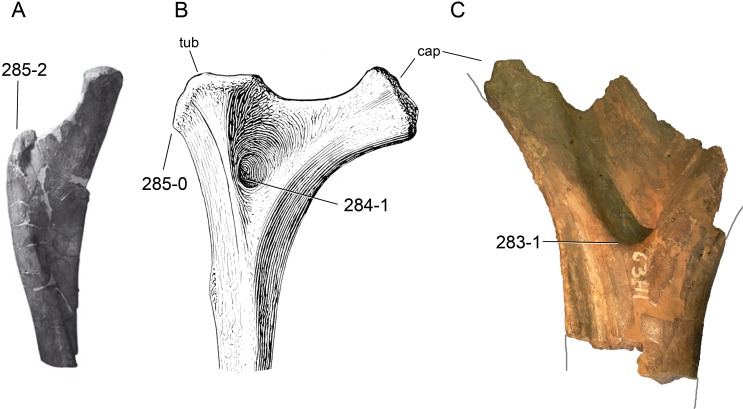
Flagellicaudatan dorsal rib heads.Dorsal rib heads of Suuwassea emilieae ANS 21122 (A; modified from Harris, 2006b), Apatosaurus louisae CM 3018 (B; modified from Gilmore, 1936) and Barosaurus lentus AMNH 6341 (C, fragment) in anterior (A, B) and posterior (C) view. Note the transverse ridge (C; C283-1), the pneumatic foramen (B; C284-1), and two of three different orientations of the tuberculum in respect to the rib shaft (C285). Grey lines in C indicate the continuation of the rib if complete. Abb.: cap, capitulum; tub, tuberculum. Not to scale.